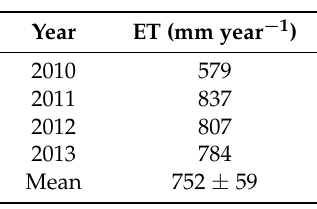
Table 1. Annual evapotranspiration (ET) from